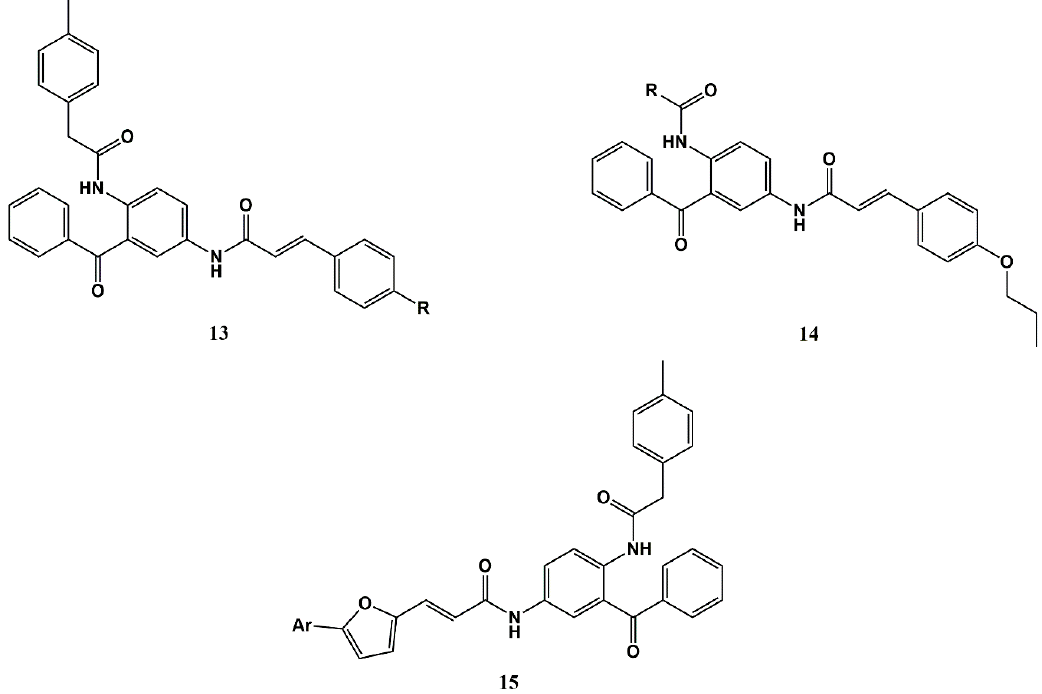
Figure 6. Antimalarial-cinnamic acid conjugates and analogues reported by Wiesner et al. [29,67,68].